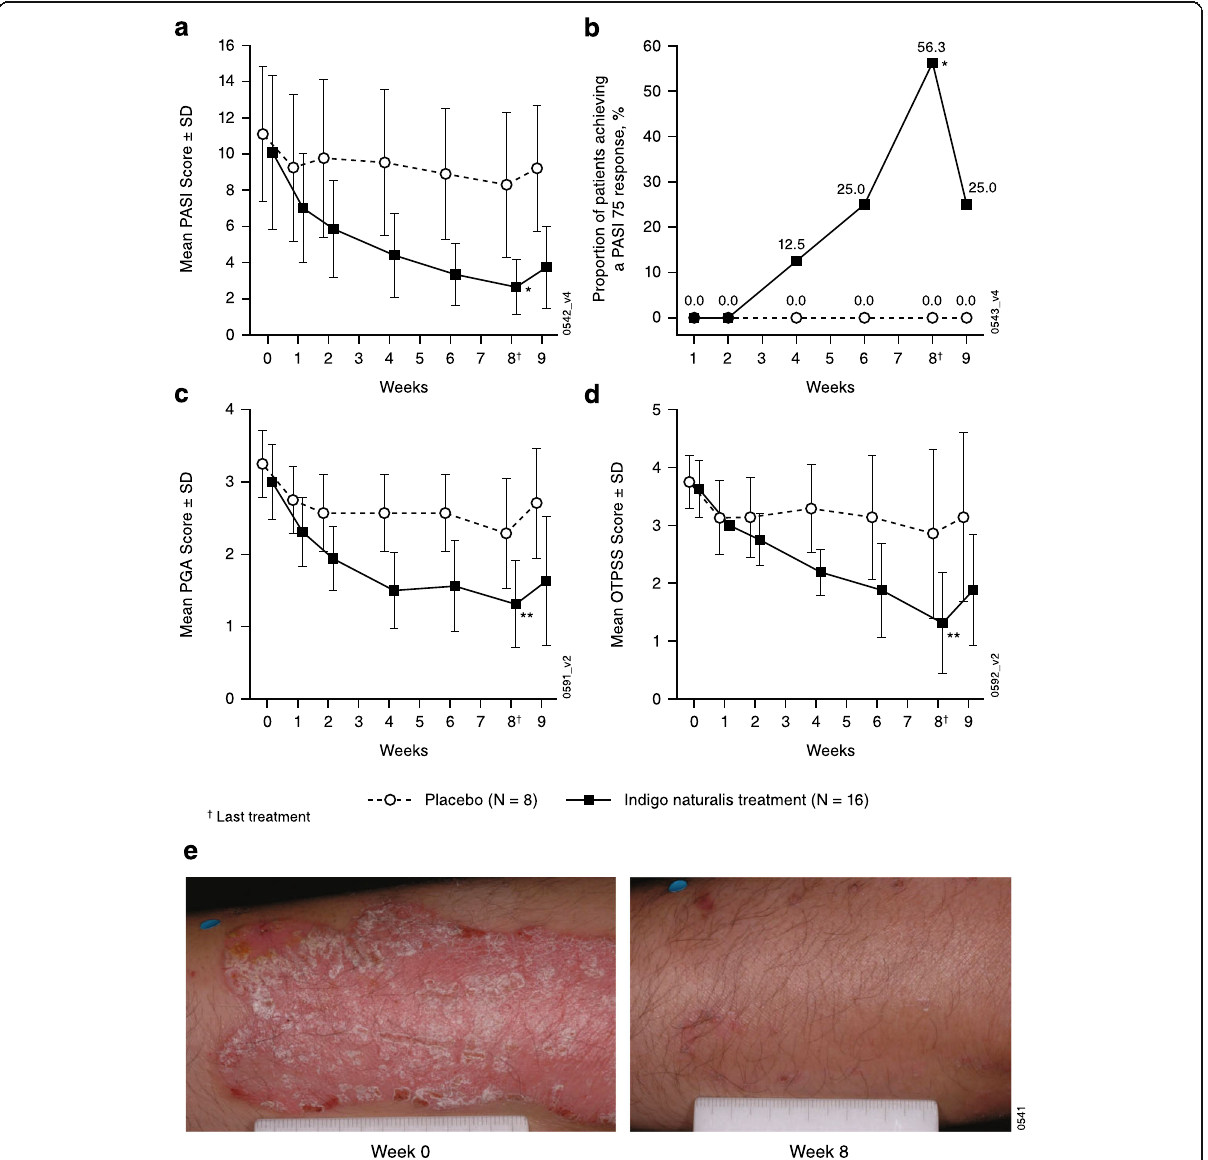
Fig. 2 Efficacy assessments. ( a ) Mean PASI scores; ( b ) proportion of placebo- and Indigo naturalis -treated patients achieving a PASI 75 response (PASI 75 responders); ( c ) mean PGA scores; ( d ) and mean OTPSS in placebo- and Indigo naturalis -treated patients by study visit; ( e ) photo of